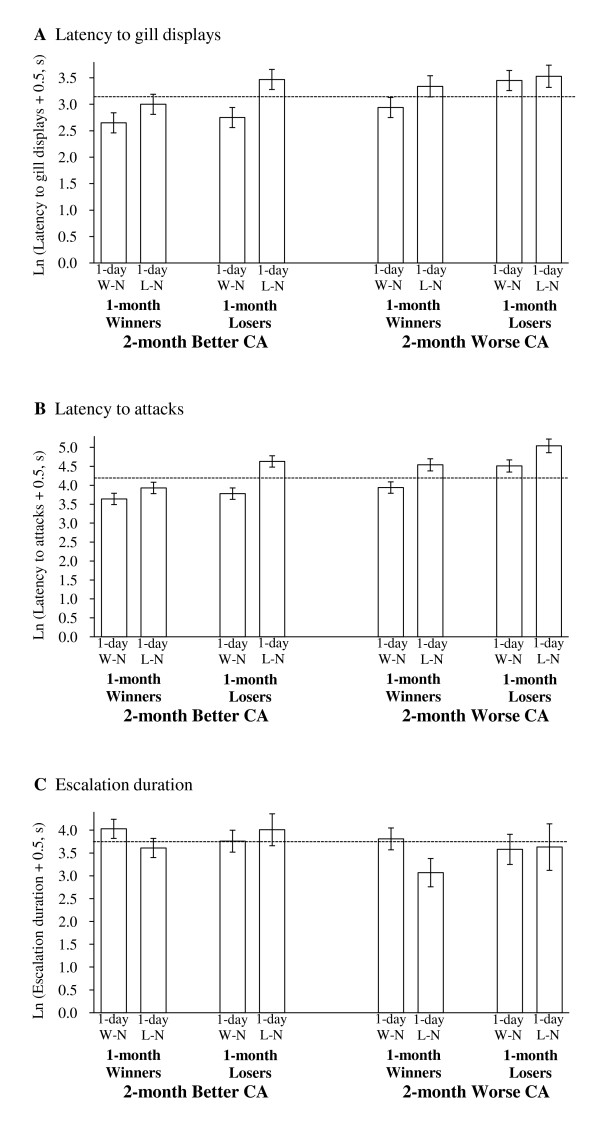
Contest behavior for the eight treatment groups. The bars represent the mean responses (ln transformed, mean ± SE) for (A) latency to gill displays, (B) latency to attacks and (C) escalation duration for the eight treatment groups. The dashed line indicates the grand mean.